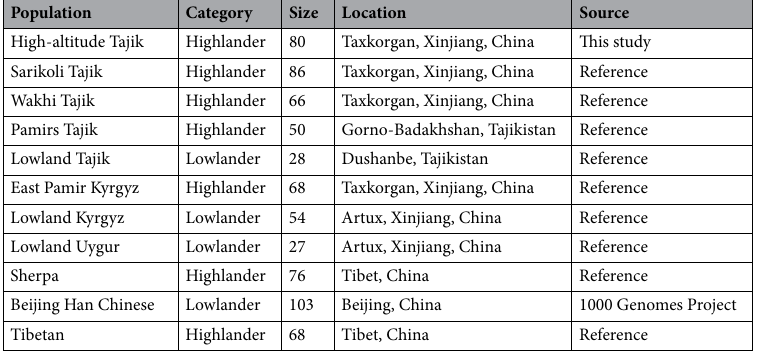
Table 1. Basic information of the populations enrolled in this